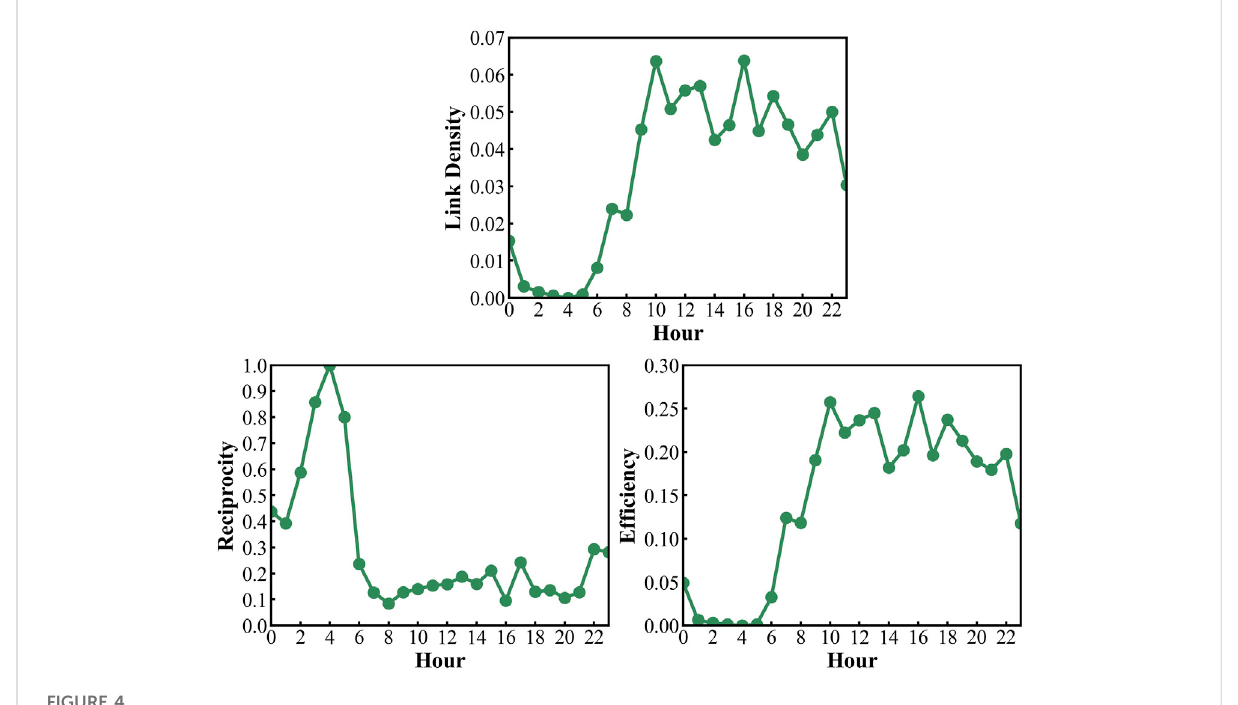
FIGURE 4 Evolution of delay propagation network